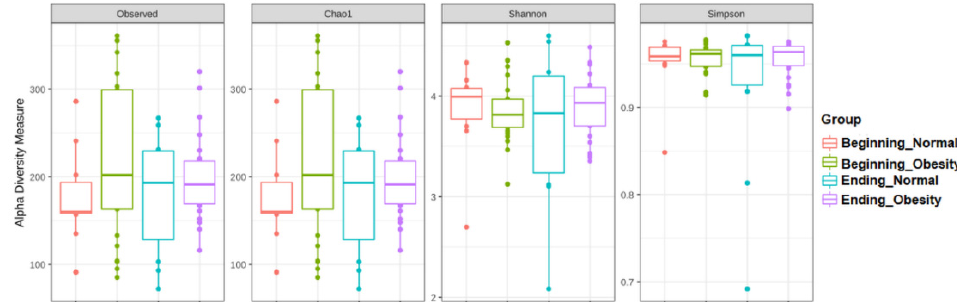
Figure 2. Alpha diversity of bacteria in fecal samples during nopal diet intervention. The figure shows data for normal weight and obesity groups at beginning and ending of nopal diet. The Y-axes indicate the values for the corresponding indexes: Observed number of species (Observed), expected bacterial richness (Chao1), and Shannon and Simpson diversity indexes. See Table S4.